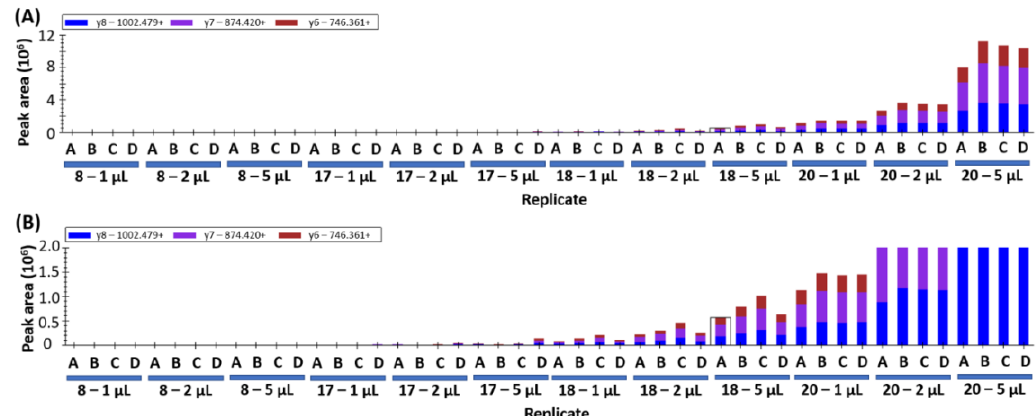
Figure 6. Barley peptide (VFLQQQCSPVR from B-hordein, UniProt: I6SJ22) peak area measurement using increasing injection volumes (1, 2, and 5 µ L). The four technical replicates are indicated by the letters A-D, the colored columns indicate the peak area for the three MRM transitions. ( A ) shows the full range of peak area, whilst ( B ) shows a zoomed in y -axis allowing the view of the trace level gluten detection in samples 17 and